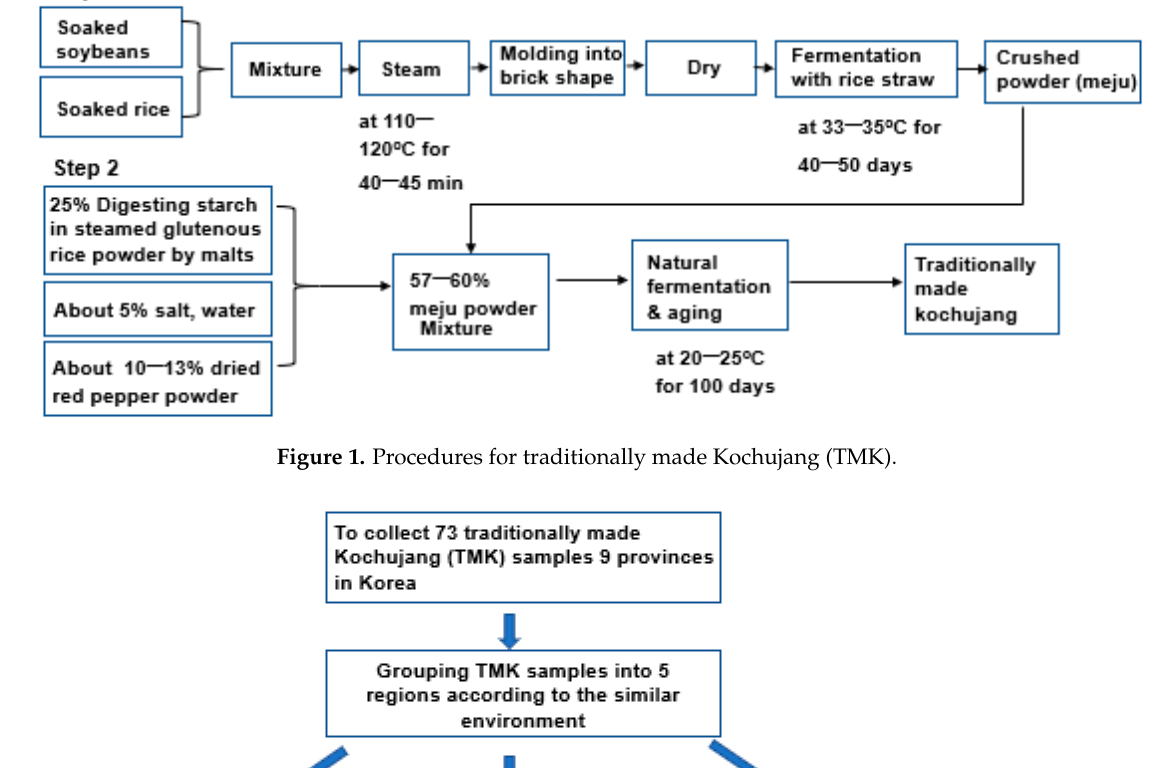
Figure 1. Procedures for traditionally made Kochujang (TMK).